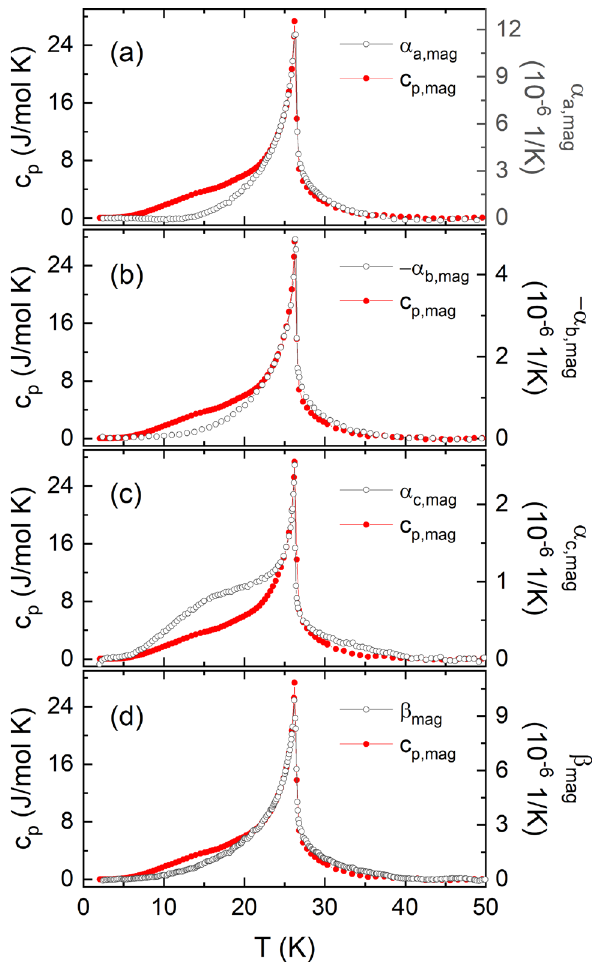
Figure 2. Grüneisen Scaling: Comparison of magnetic contributions to the specific heat (red circles, left axes) and thermal expansion (empty black circles, right axes) along the ( a ) a axis, ( b ) b axis, ( c ) c axis, and ( d ) for the volume